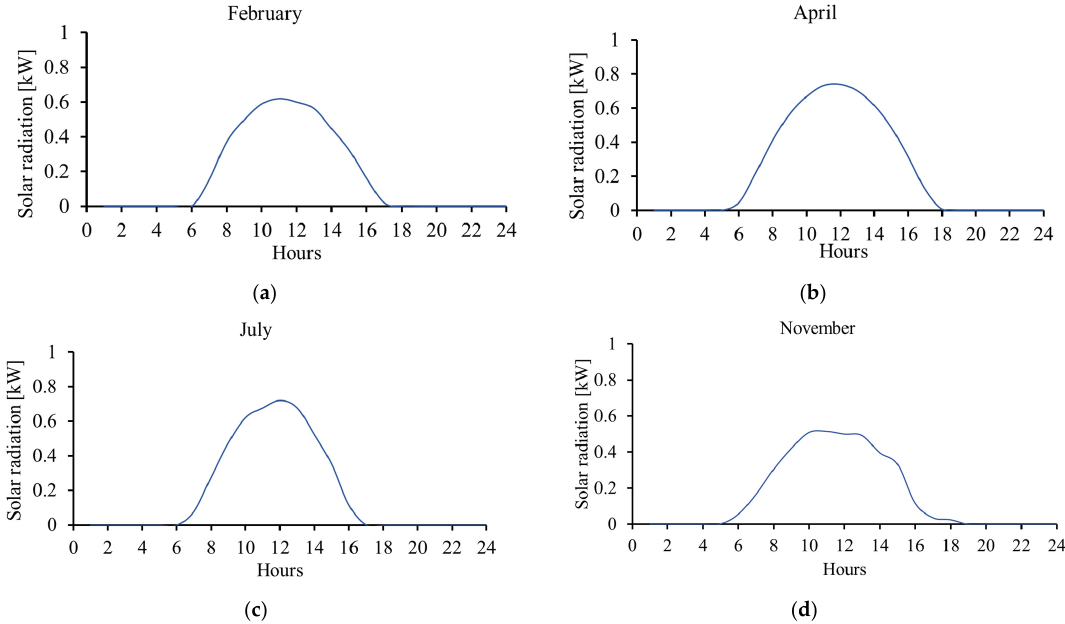
Figure 1. The hourly trend was recorded in February ( a ), April ( b ), July ( c ), and November ( d ) in the year 2019. year